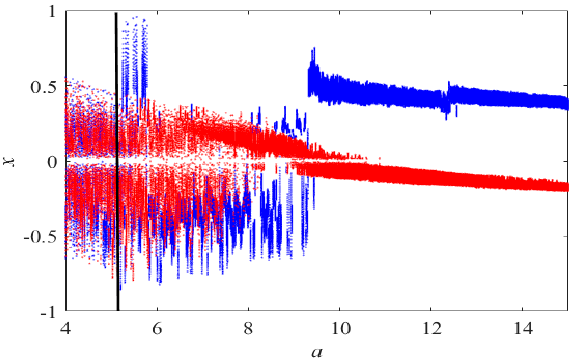
Figure 4. Coexisting bifurcation diagram of the state variable x with respect to the control parameter a.